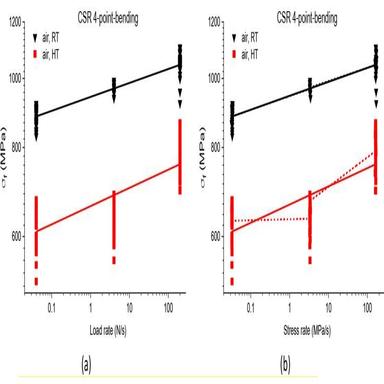
CSR data from 4PB tests shown in logarithmic scale (a) strength vs. load rate, (b) strength vs. stress rate.